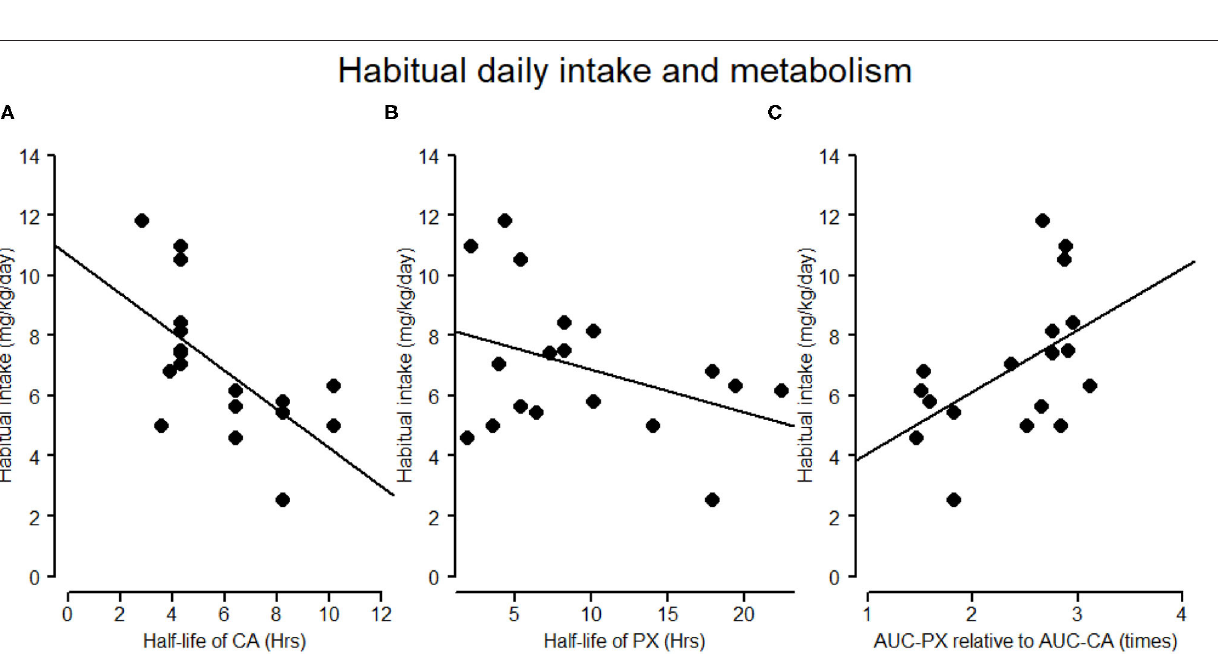
( t W − C = 3.2, p W − C = 0.003). On the other hand, CBF